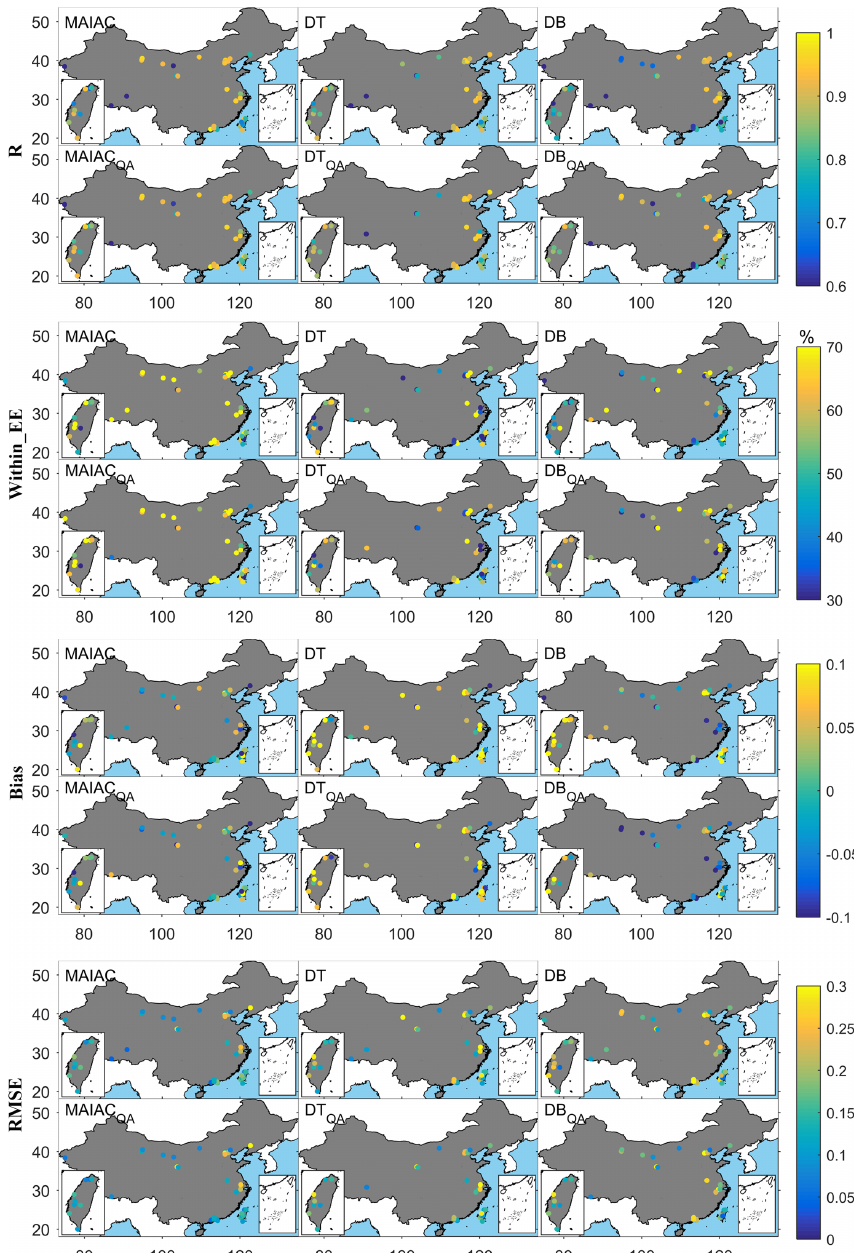
Figure 9. Evaluation results for MAIAC, DT, and DB after and before the QA filter in each AERONET site. The subscript QA denotes the corresponding results after the QA